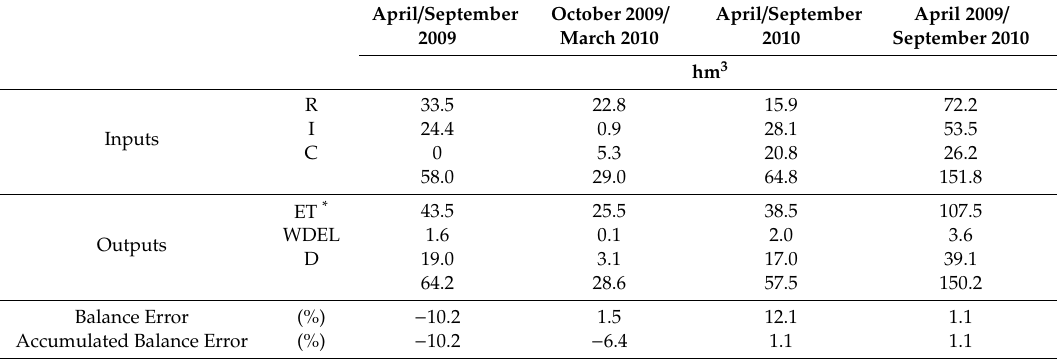
Table 2. Inputs (rainfall, R; irrigation, I; and Terreu irrigation canal discharge, C), outputs (evapotranspiration, ET; drainage, D; and wind drift and evaporation losses in the sprinkler irrigation system, WDEL), and estimated errors in the Clamor Vieja basin water balance between April 2009 and